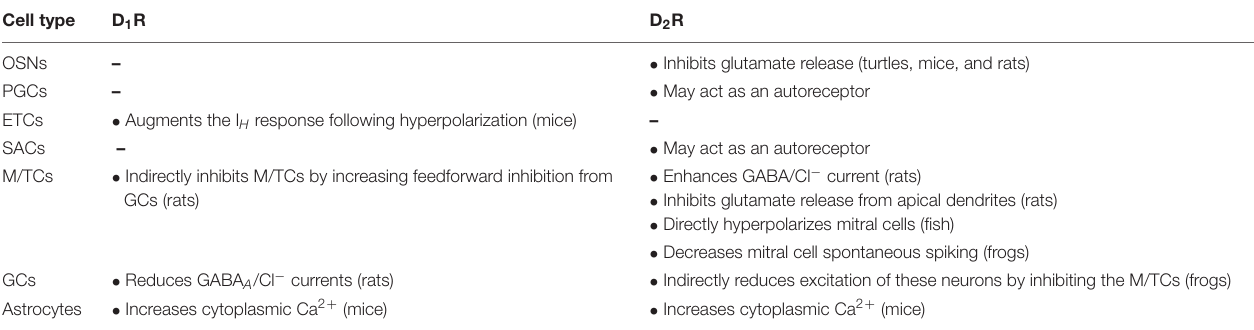
TABLE 2 | Neuromodulatory effects of dopamine receptors on olfactory bulb neurons and